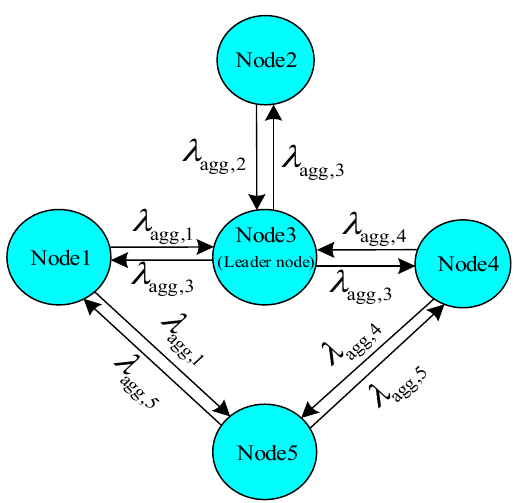
Figure 5. Communication topology of the five mobile energy storage clusters (MESCs) system.